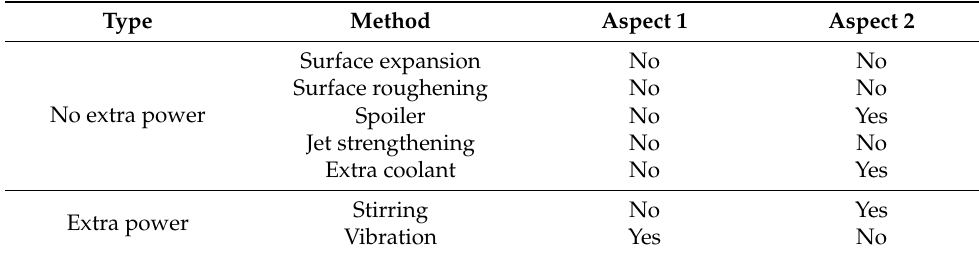
Table 3. Methods to enhance the convective heat transfer coefficient in engineering practice.